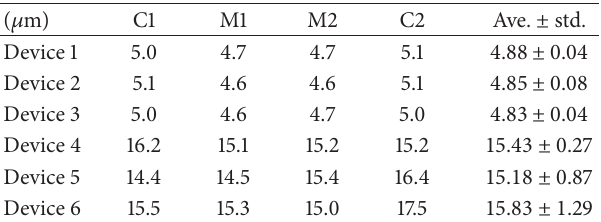
Table 2: Thickness quantification results of single-layer SU-8. Device1toDevice3withexpected5 𝜇 mSU-8andDevice4toDevice 6 with expected 15 𝜇 m SU-8. “C” represents the corner area and “M” represents the central area of the devices, respectively. Average ± standard